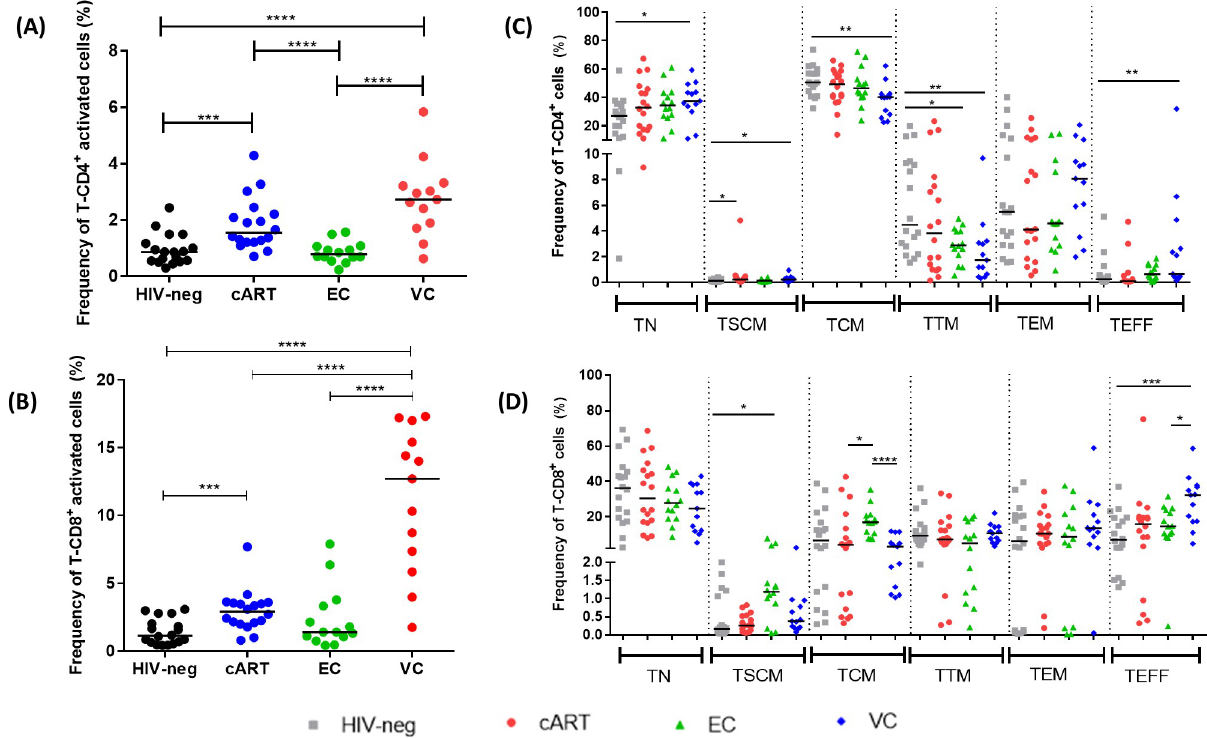
Fig 1. T cell activation levels and subset profiles in HICs and control groups. (A) Frequencies of activated CD4 + (CD38 + HLA-DR + ) T cells. (B) Frequencies of activated CD8 + T cells. (C) Frequencies of na ï ve (TN; CD45RA + CCR7 + CD27 + CD95 - ), stem memory (TSCM; CD45RA + CCR7 + CD27 + CD95 + ), central memory (TCM; CD45RA - CCR7 + CD27 + ), transitional memory (TTM; CD45RA - CCR7 - CD27 + ), effector memory (TEM; CD45RA - CCR7 - CD27 - ), and effector (TEFF; CD45RA + CCR7 - CD27 - ) CD4 + T cells. (D) Frequencies of TN, TSCM, TCM, TTM, TEM and TEFF CD8 + T cells. For panels C and D, gray squares represent HIV-neg, red circles represent cART, green triangles represent ECs and blue diamonds represent VCs; the horizontal line represents the median for the group; P-values were calculated using the Mann-Whitney test in GraphPad Prism and are represented as follows: � p < 0.05; �� p < 0.01; ��� p < 0.001; ���� p < 0.0001.